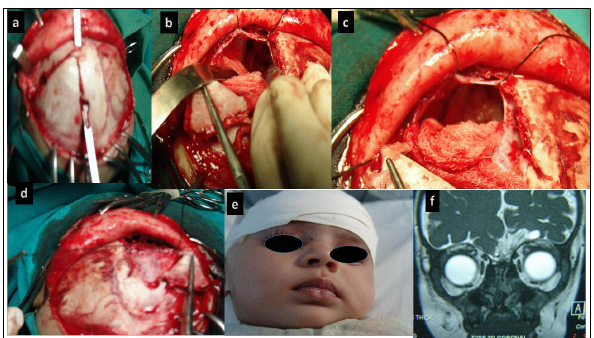
Figure 2: a.Temporal based flap, b. Defect in cribriform, c. Fat plug in defect, d. Dural closure, e. Dry nose immediately at recovery, f. Follow up MR ( 9